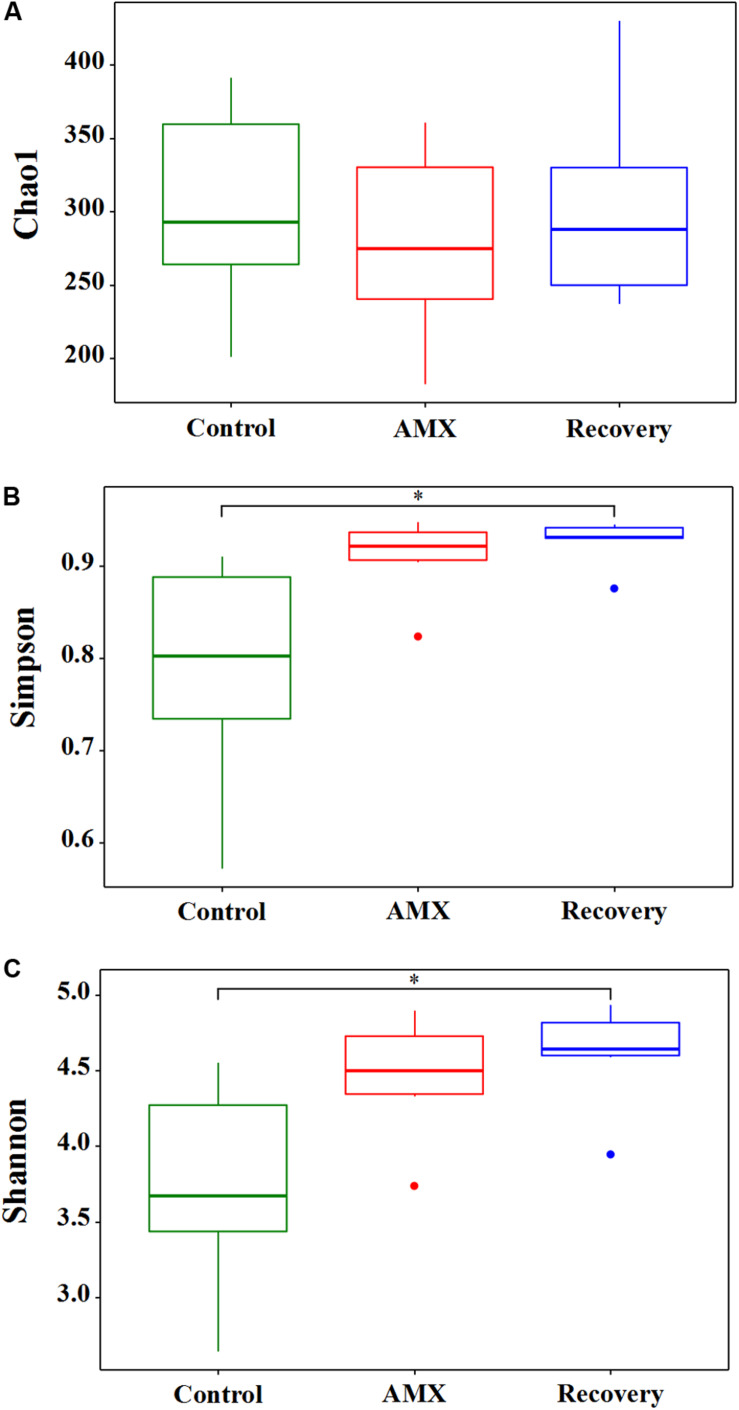
Effects of AMX treatment on gut microbiota alpha diversity of the control (green), AMX (red), and recovery (blue) groups. The Chao1 index (A) was used to calculate the community richness, Simpson index (B) was used to calculate the community evenness, and Shannon index (C) was used to calculate the community diversity within each of the three groups (control, AMX, and recovery). Statistical significance between each of the three groups were analyzed using the T test at a significance level of 0.05.